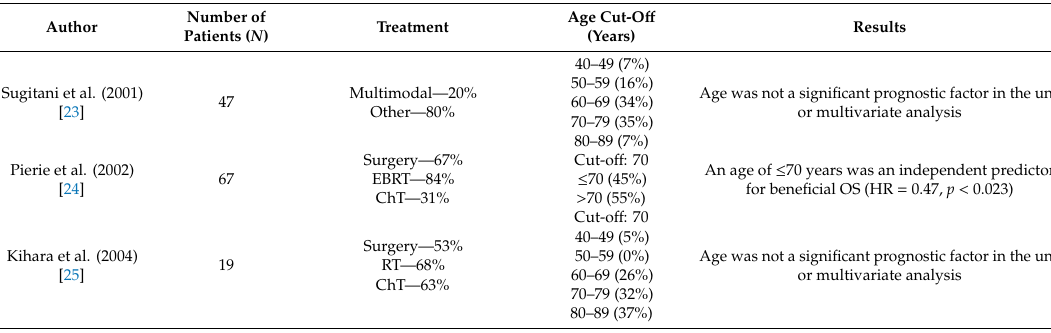
Table 1. Systematic review of the literature: age as a prognostic factor in patients with anaplastic thyroid cancer